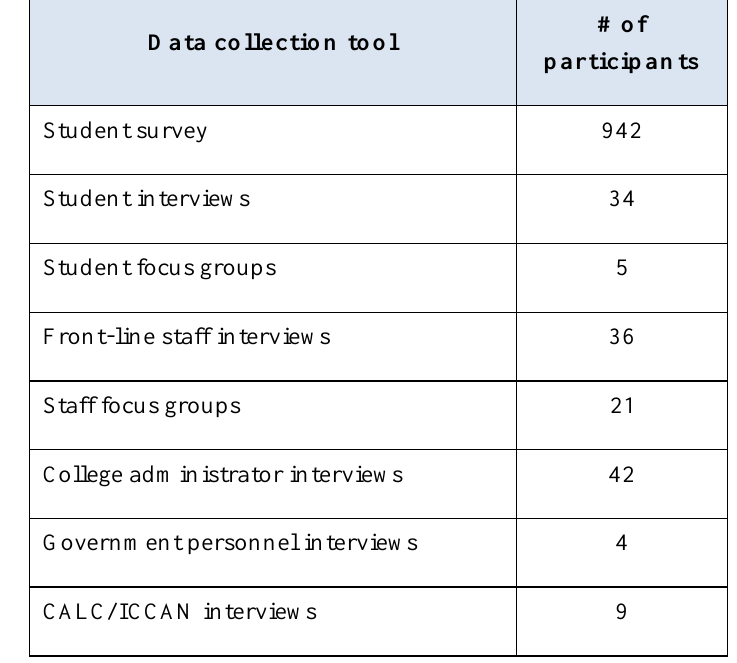
Study Participants by Data Collection Tool